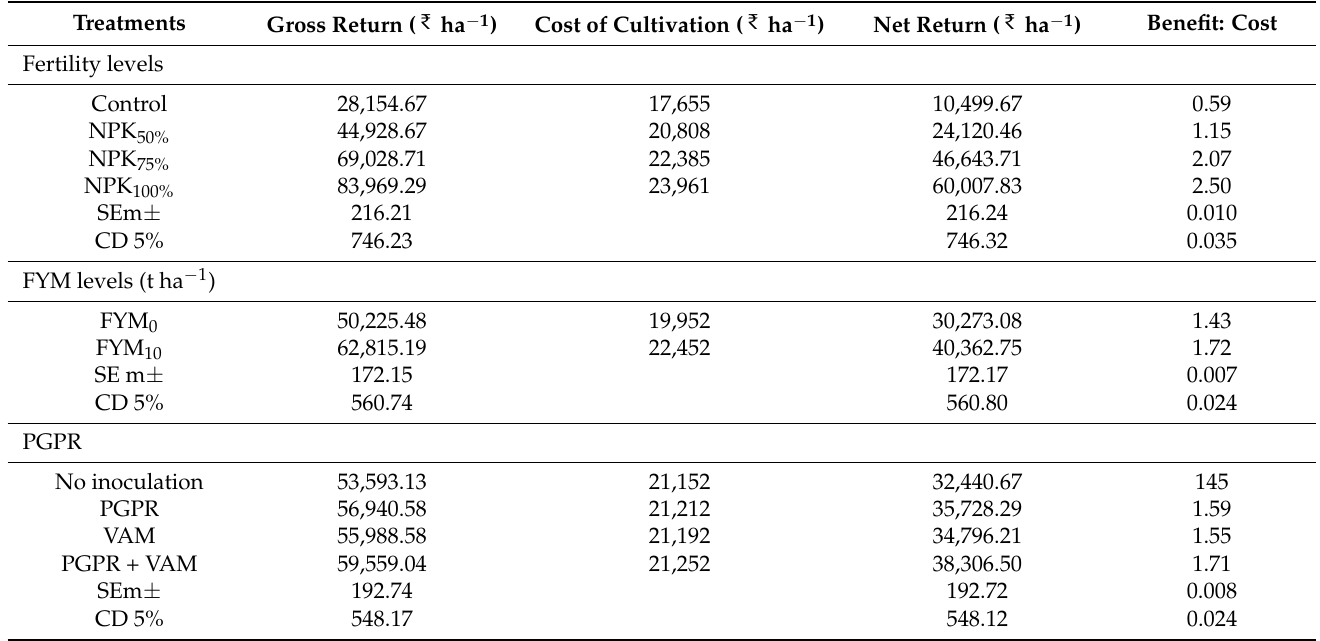
Table 8. Interaction effect of fertility levels, FYM, and bio-inoculants on the economics (B:C ratio) of wheat (mean of two years).